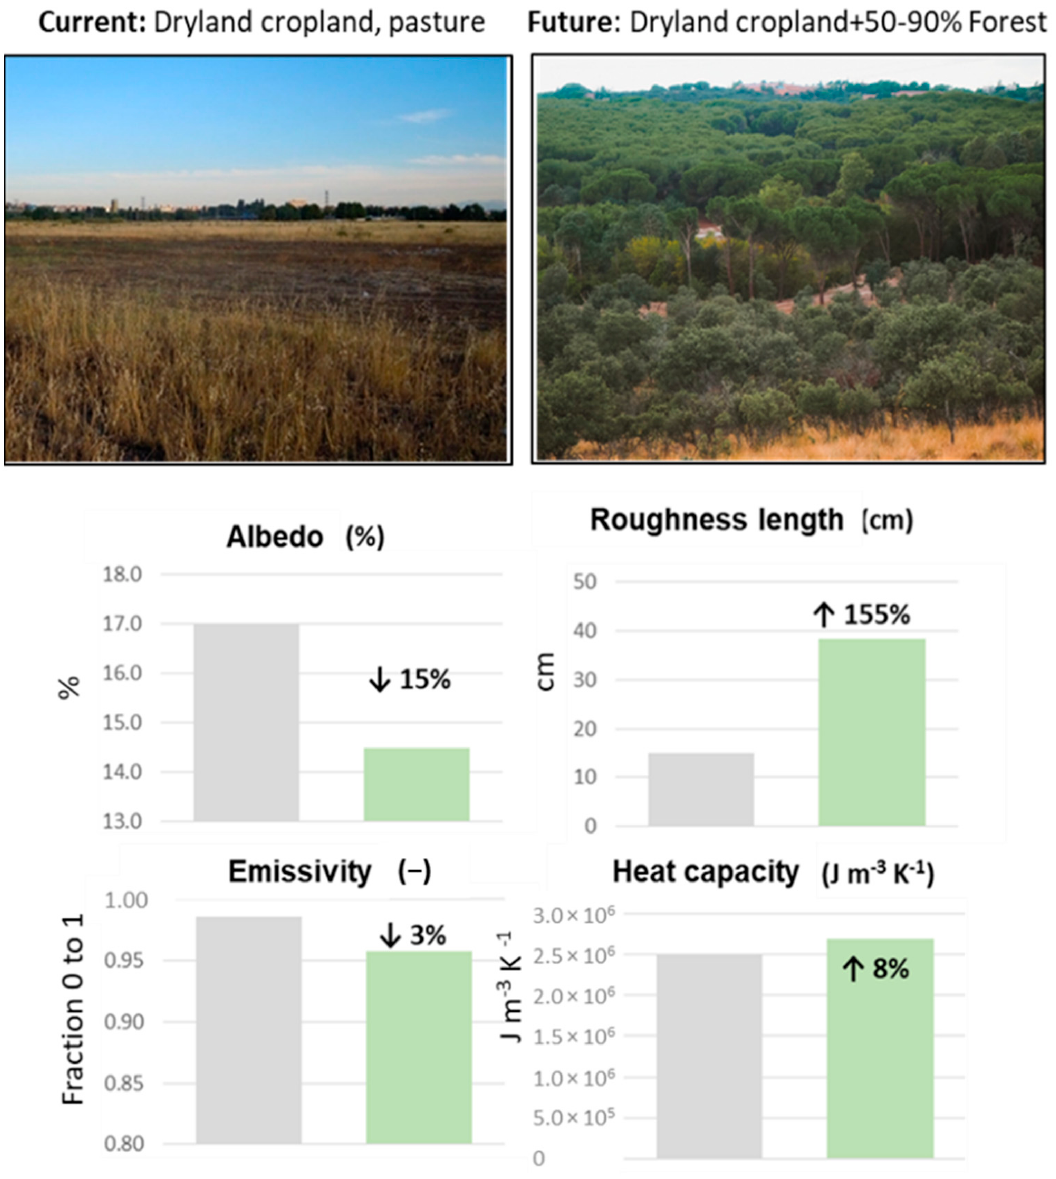
Figure 3. Values of albedo, roughness length, emissivity and heat capacity for current (grey bars) and future (green bars) scenarios for a grid cell where new trees (‘Bosque Metropolitano’) are intro- duced.